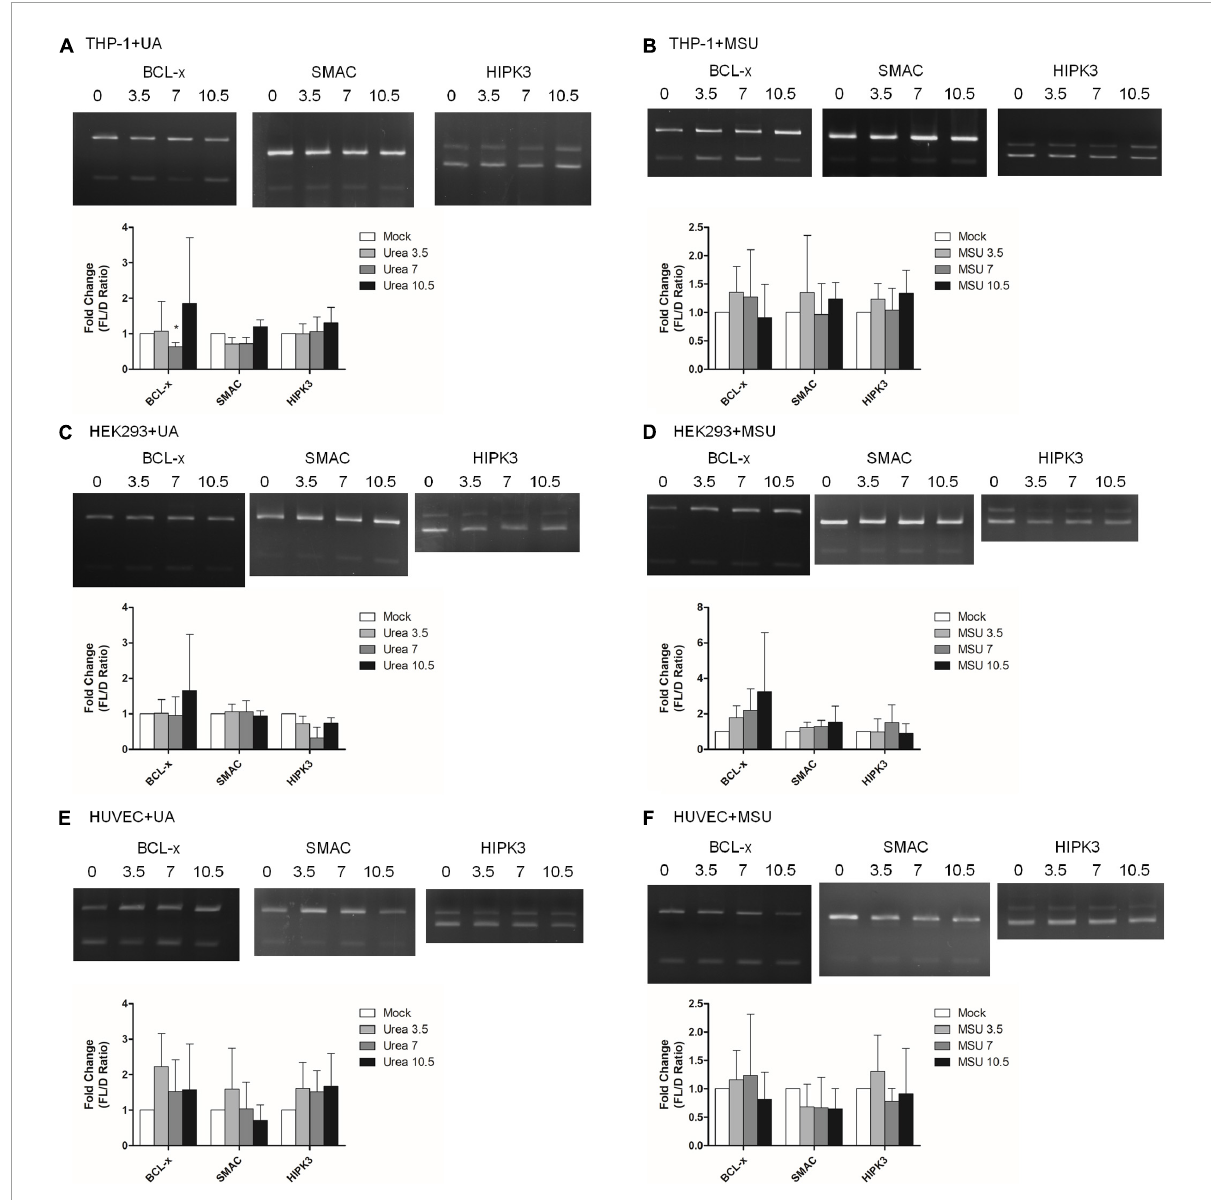
FIGURE7 RNA alternative splicing was affected in MSU- or UA-treated cell lines. The alternative splicing changes in BCL-x , SMAC , and HIPK3 were detected through RT-PCR in UA-treated THP-1 cells (A) , MSU-treated THP-1 cells (B) , UA-treated HEK293 cells (C) , MSU-treated HEK293 cells (D) , UA-treated HUVEC cells €, and MSU-treated HUVEC cells (F) . The PCR product sizes of BCL-x were 318 and 129 bp, those of SMAC were 250 and 118 bp, and those of HIPK3 were 244 and 181 bp. The bottom bar graphs indicate the fold change of full-length form (FL) and truncated form (D) mRNA ratios quantified using LabWorks Image Acquisition and Analysis Software (UVP BioImaging Systems, Upland, CA, United States). Error bars represent standard deviation. Representative results from three independent experiments are presented. The results of three independent experiments were averaged to obtain the final results. * P < 0.05 by Student’s t -test, compared with mock